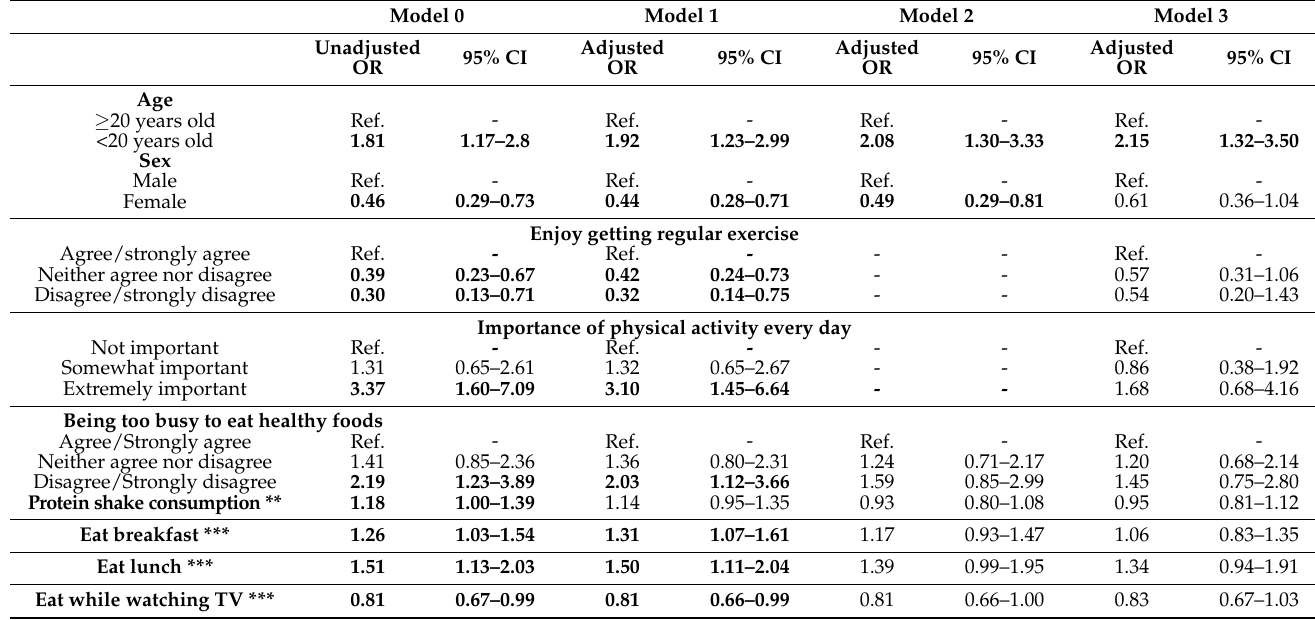
Table 2. Assessment of the factors associated with increased physical activity.